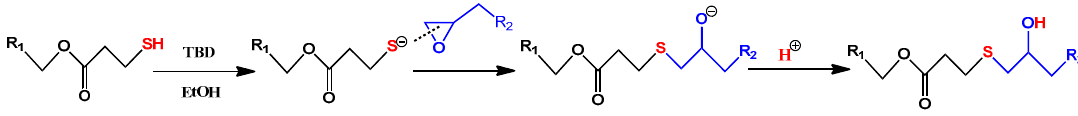
Figure 1. Preparation process of TO / TMMP-TMTGE self-healing composite.